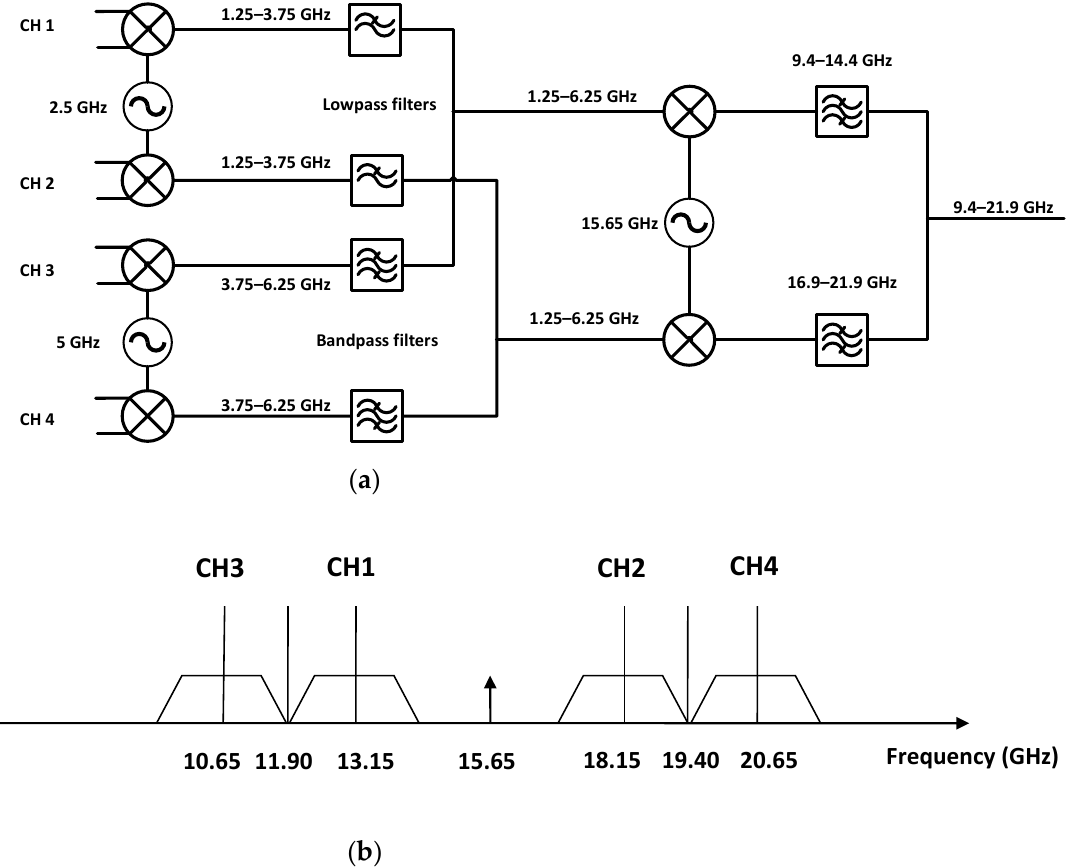
Figure 4. ( a ) Schematic of the IF module, and ( b ) the frequency assignment of the base-band chan-